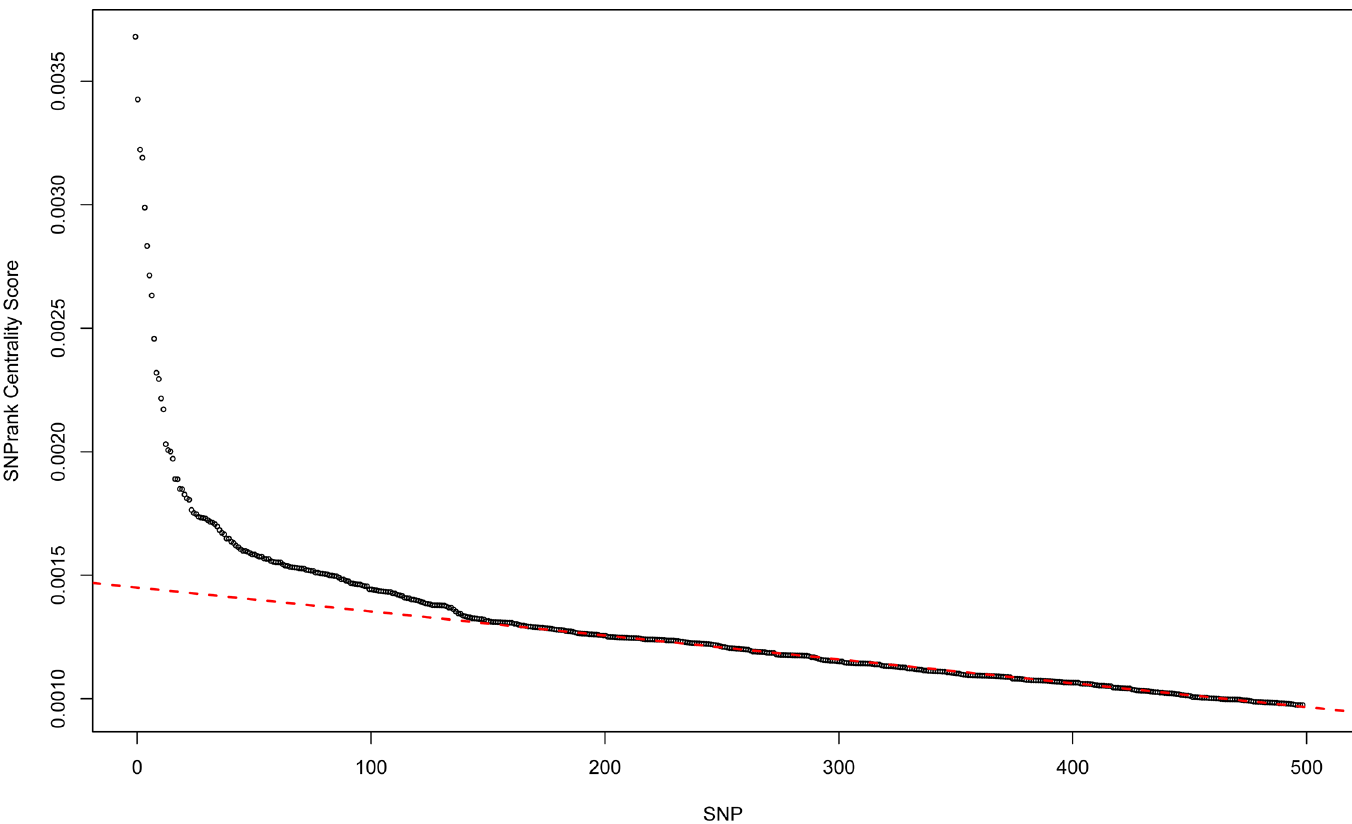
Fig 2. SNPrank centrality score elbow plot. The SNPrank scores are plotted for the top 500 variants. The red dashed line represents the null centrality line.